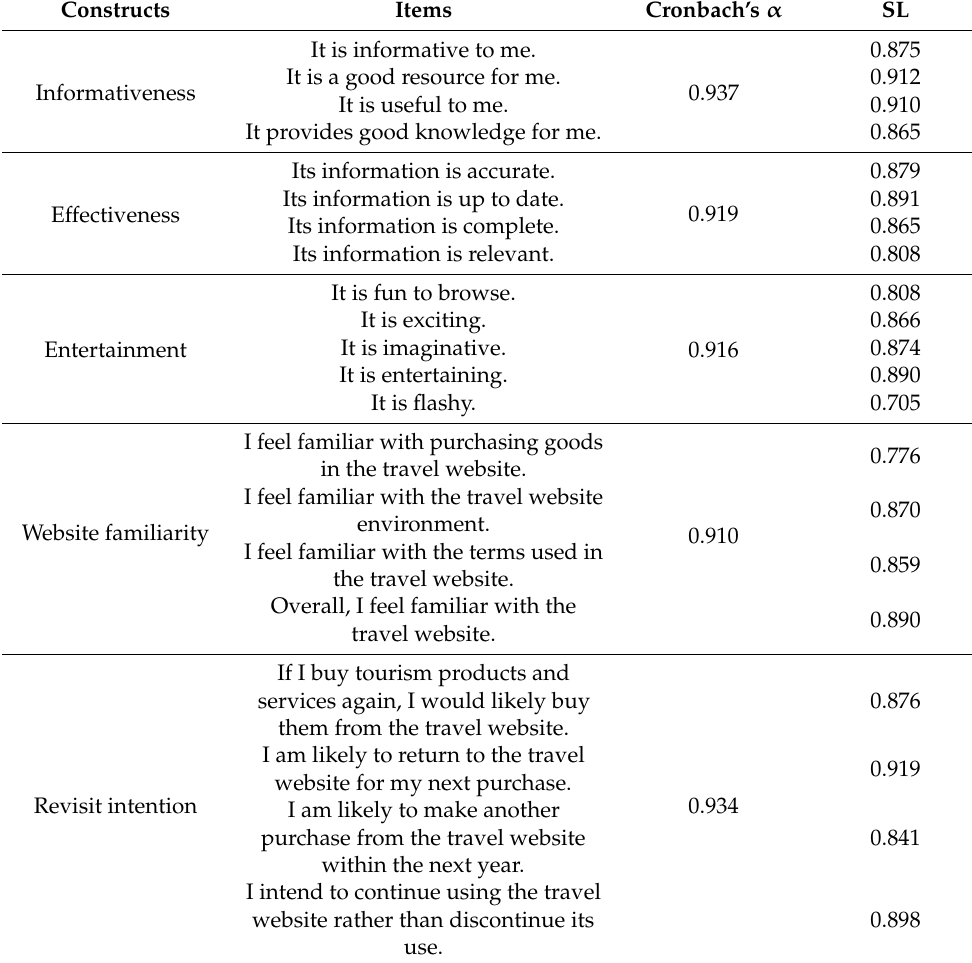
Table 2. Confirmatory factor analysis: items and